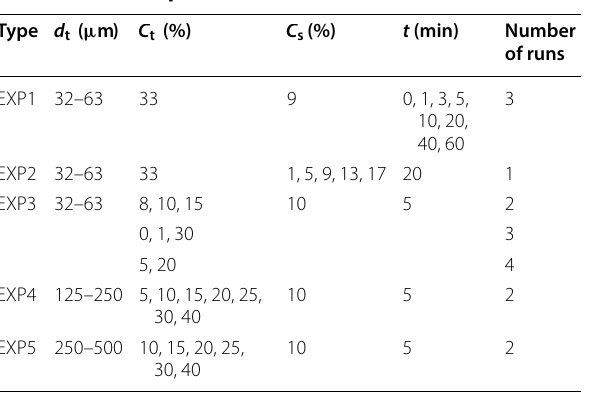
Tephra diameter, tephra and snow concentrations for water volume, and the rotation time are denoted by d t , C t and C s , and t , respectively